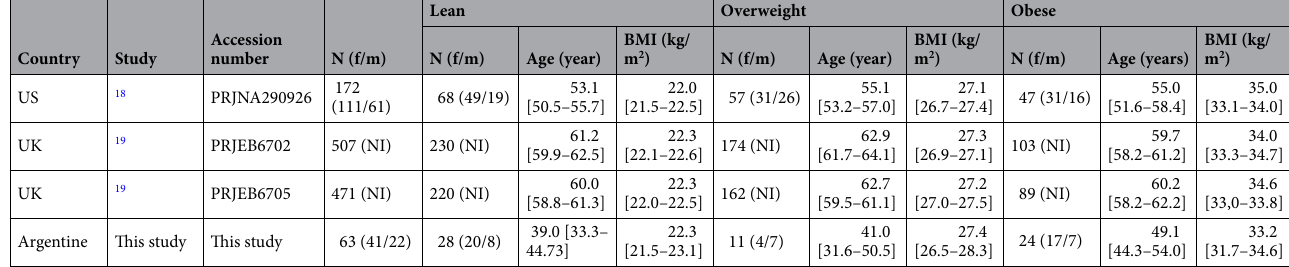
Table 2. Description of studies considered to compare geographical population. N population size, f female, m male. Age and mean expressed as mean and 95% CI. NI not